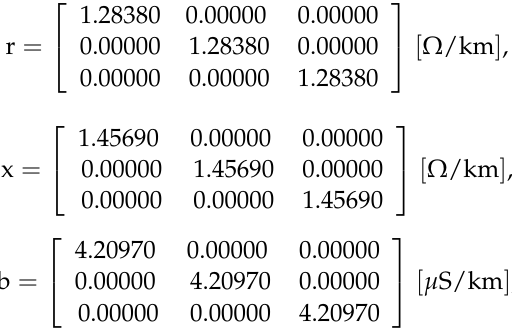
The lines also have the same lengths equal to 0.075 km. The main circuit breaker that connects the microgrid to the utility grid is marked with MCB in Figure 5, while five other breaking devices, located at the critical positions, are marked with CB1, CB5,